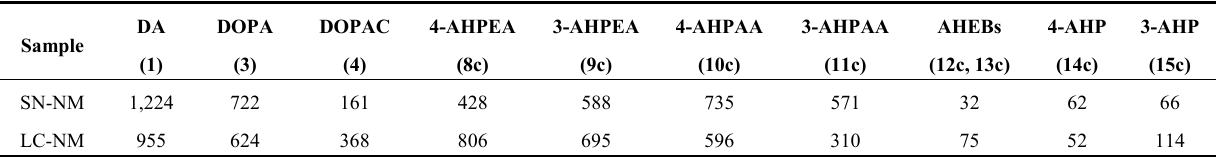
Table 1 . Chemical characterization with reductive HI hydrolysis of human NM isolated from SN and LC tissues (values in